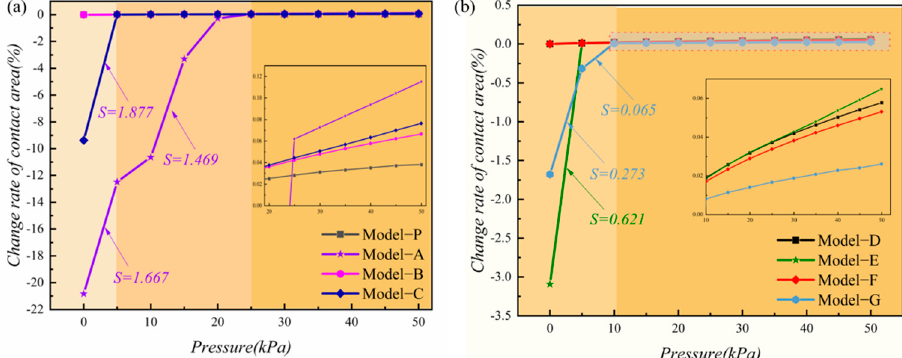
Figure 3. Change rate of contact area of different models under pressures from 0 to 50 kPa: ( a ) First set of models, Model − P and Models A − C; ( b ) The second group of models, Models D − G.